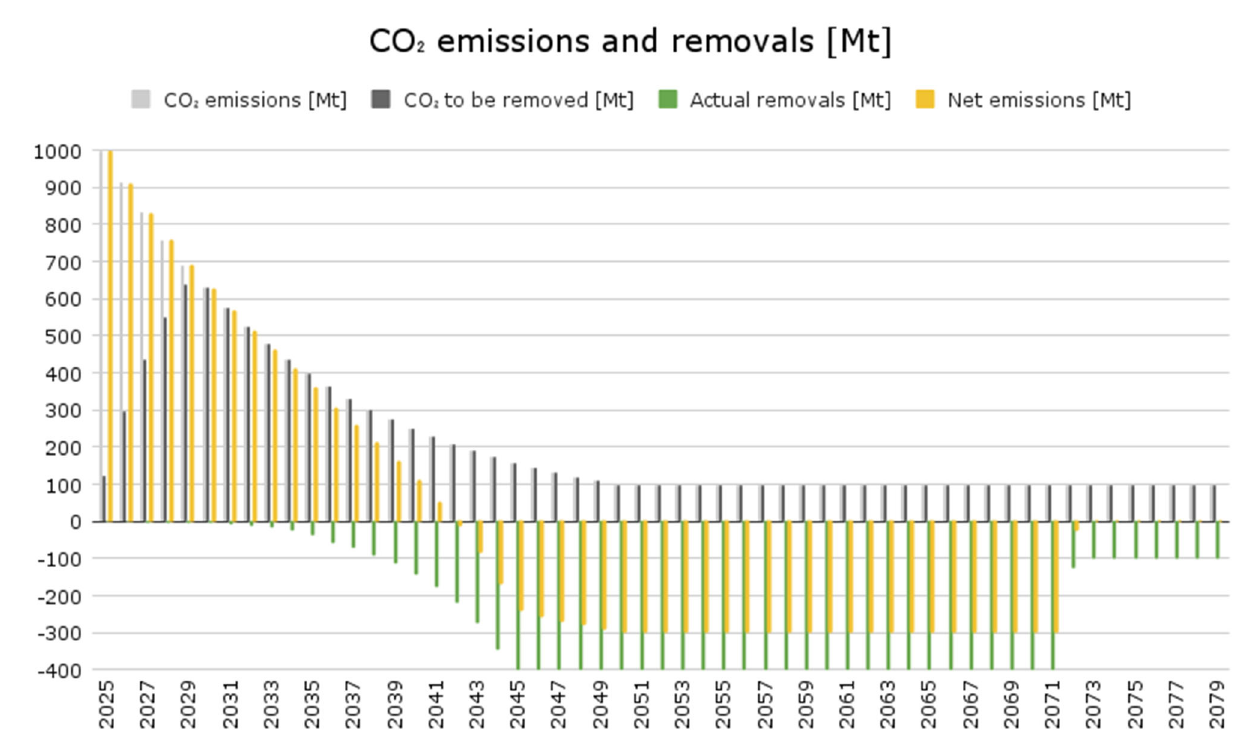
Figure 2. Simulated CO 2 flows showing global aviation reaching net zero in 2042 on an annual basis, and all aviation CO 2 from 2030 removed by 2072.